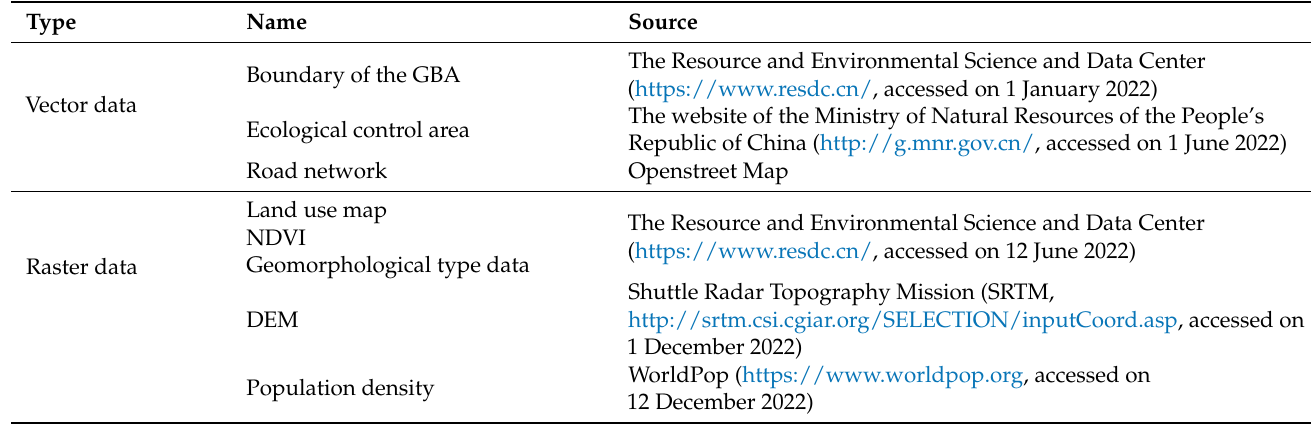
Table 1. Details of data used in the